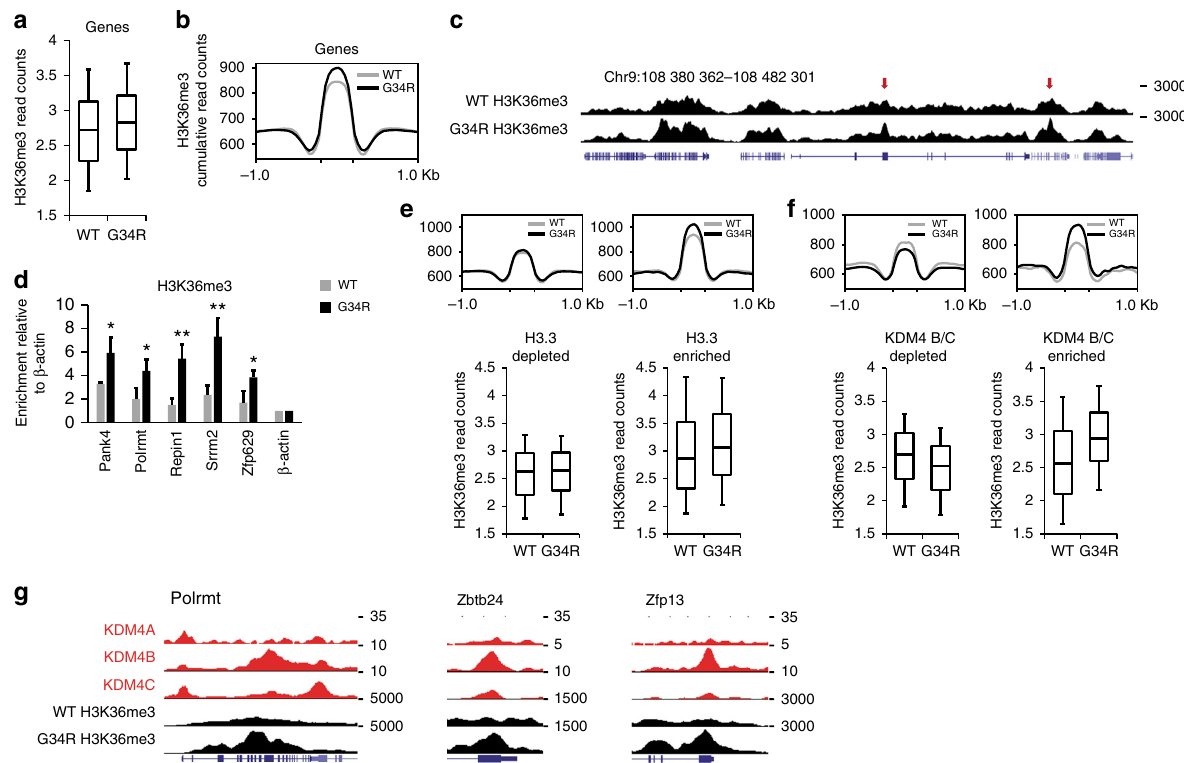
Fig. 2 H3.3 G34R triggers gains of H3K36me3 within genes in a Kdm4-associated manner. a Normalised H3K36me3 ChIP-seq reads across all H3K36me3- enriched genes in WT and G34R cells. b Cumulative ChIP-seq read counts of H3K36me3 in WT and G34R cells. c Screenshot of H3K36me3 ChIP-seq in WT and G34R mutated cells. Red arrows indicate gains of H3K36me3 at discrete genomic sites. d H3K36me3 ChIP-qPCR in WT and G34R cells. Results are normalised for input and bars represent mean enrichment of three independent experiments, calculated relative to a negative control ( β -actin promoter). Error bars represent standard deviation of three independent experiments ( n = 3). P -values calculated using Student ’ s T -test (* P < 0.05, ** P < 0.01). e Cumulative and normalised H3K36me3 read counts at H3.3 depleted ( n = 7795) and enriched ( n = 3161) genomic regions. f Cumulative and normalised H3K36me3 read counts at KDM4 B/C depleted ( n = 4950) and enriched ( n = 618) genomic regions. g Screenshots of WT-KDM4 A/B/C and H3K36me3 in WT and G34R cells at three representative genes: Polrmt , Zbtb24 and Zfp13 . ChIP-seq of KDM4-A 36 , -B and -C 37 were obtained from GEO (accession number GSE64252 and GSE43231, respectively). Boxes represent 25th, median and 75th percentile; whiskers represent 10th and